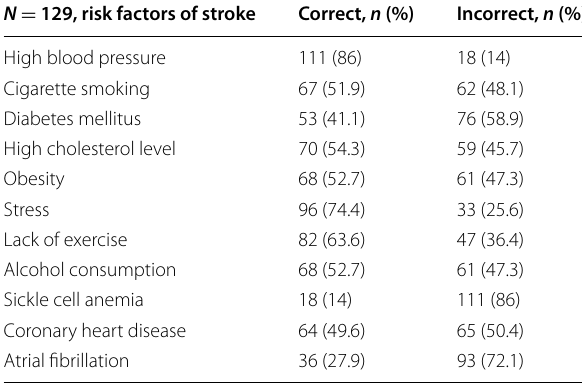
Table 4 Participant awareness of the individual risk factors of